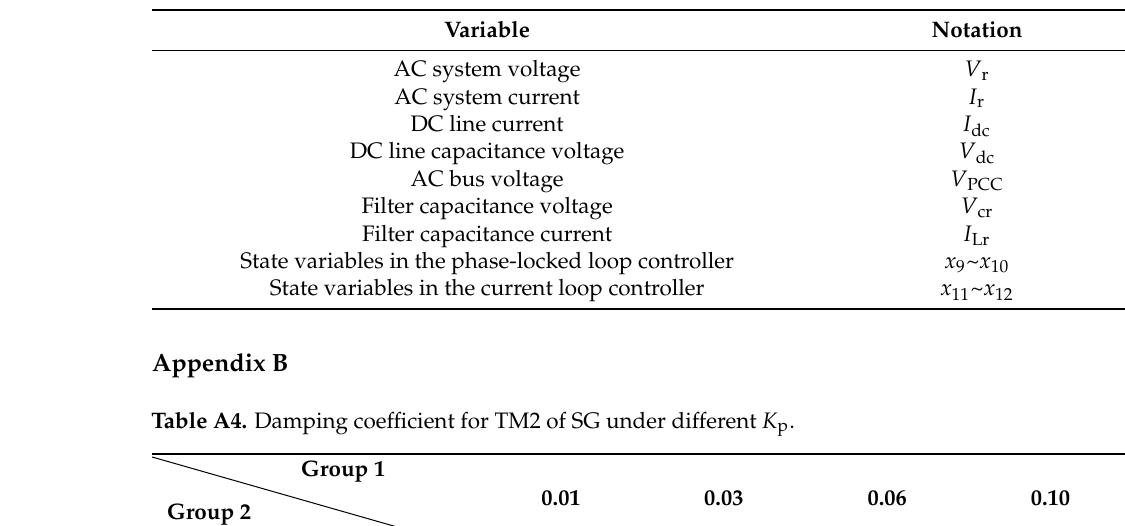
Table A3. The definitions of variables for HVDC.